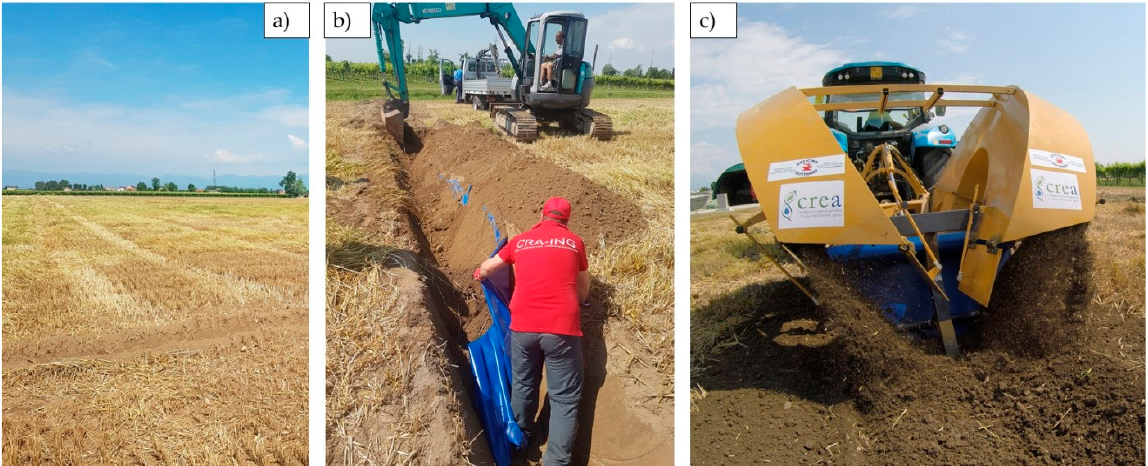
Figure 4. Views of ( a ) the field before building the SWRS, ( b ) removal of the SWRS using the excavator, and ( c ) SWRS machinery at work. Table 4. Financial, fixed and variable costs